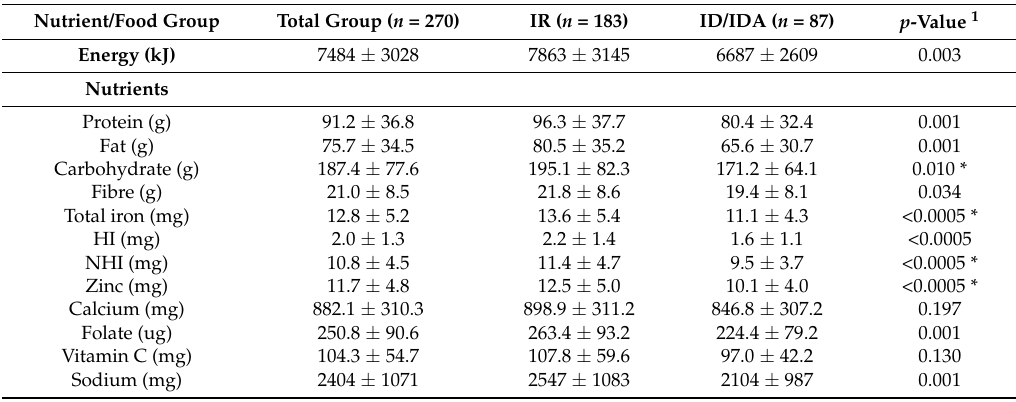
Table A1. Mean daily nutrient and food group